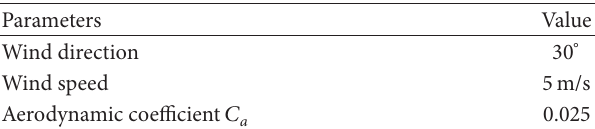
Table 2: Parameters for